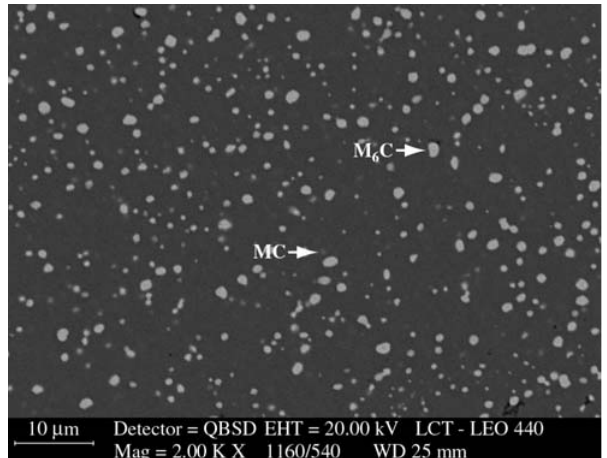
Figure 5. M C and MC type carbides identified using EDS. 6